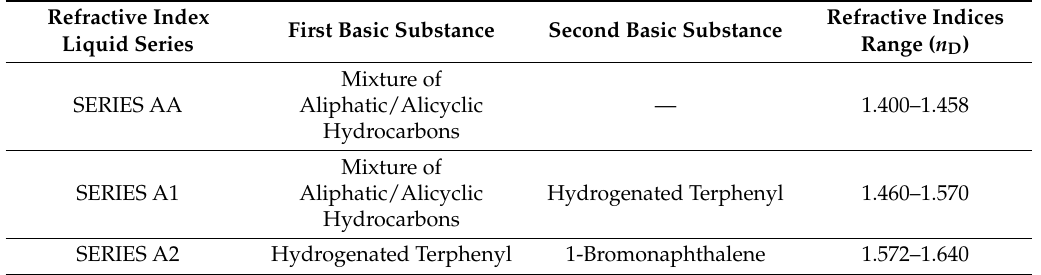
Table 1. Series of Cargille refractive index liquids that were used for the experiments.